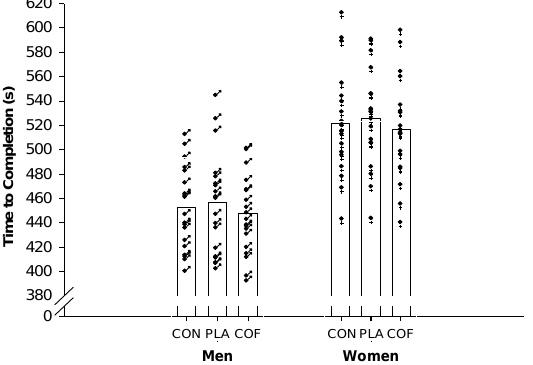
Figure 2. Mean (represented by the bar) and individual men ( ♂ ) and women ( ♀ ) 5 km cycling time trial completion.